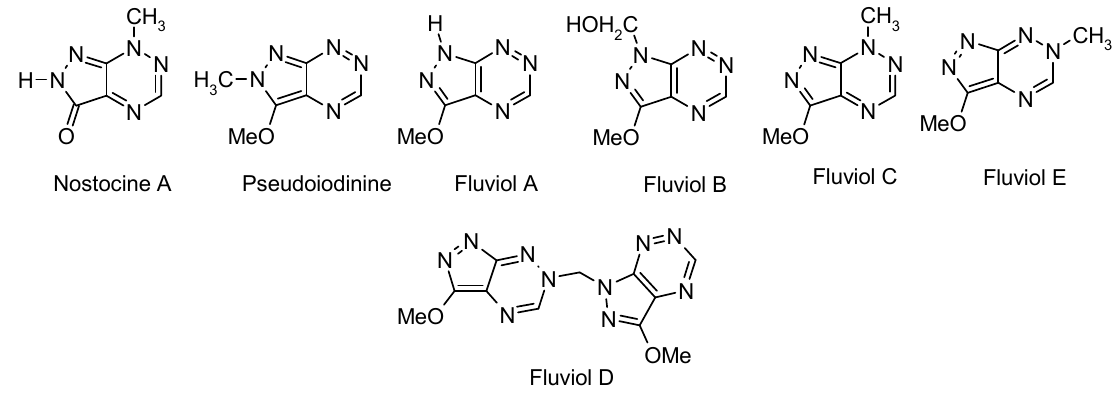
Figure 1. Naturally occurring pyrazolo[4,3- e ][1,2,4]triazines.